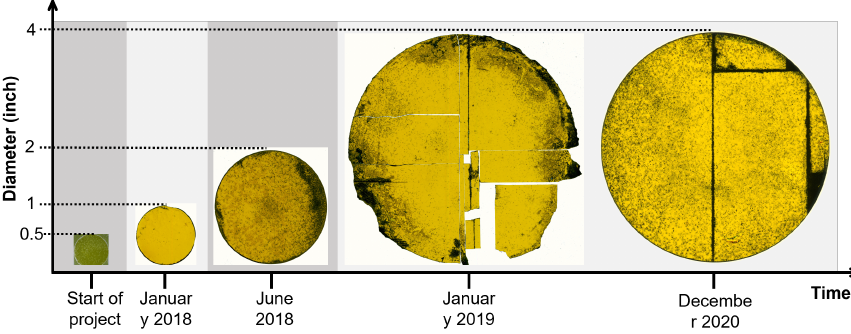
Figure 11. Evolution of diameters for bulk 3C-SiC crystals grown by sublimation growth during CHALLENGE project with indicated timeline. With permission from [145].